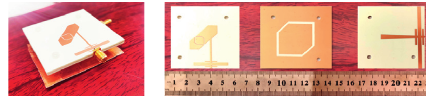
Figure 4: Antenna prototype.